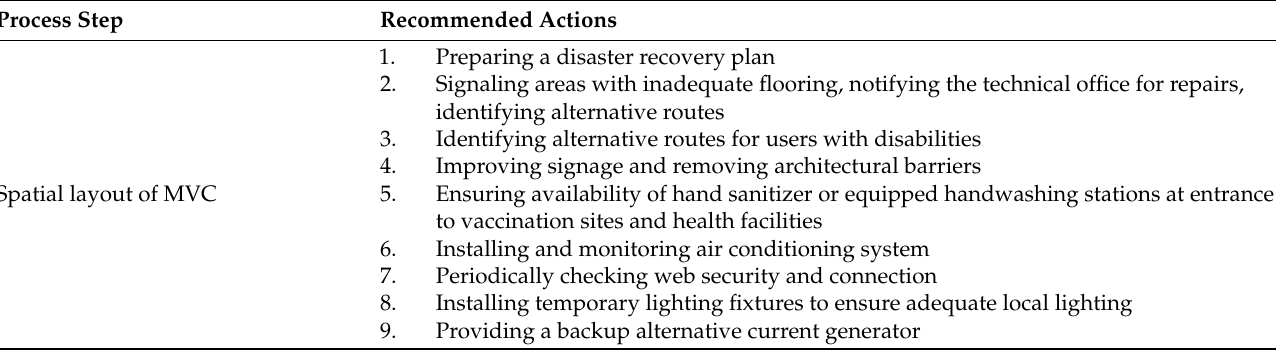
Table 3. Actions recommended to improve the mass vaccination